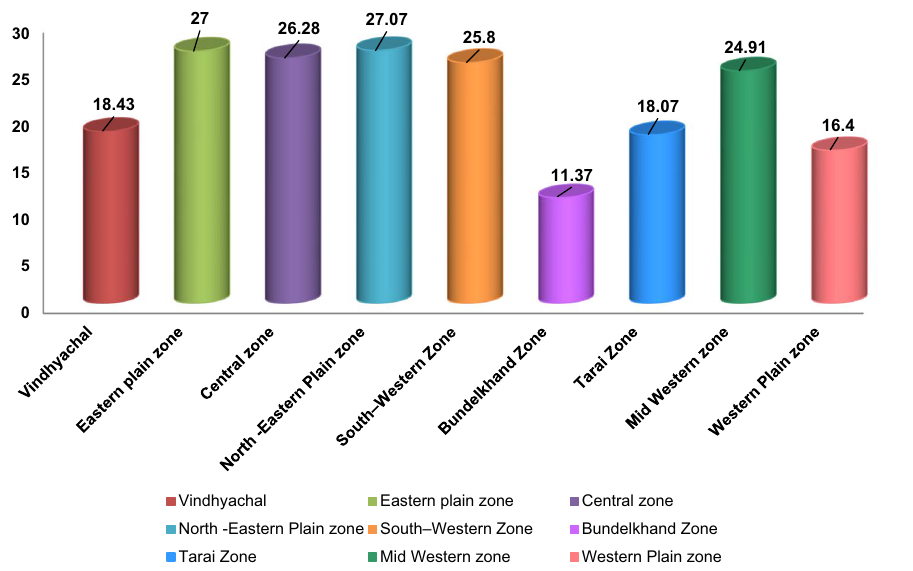
Figure 2. Viral disease incidence on cucurbits across the different agroclimatic zones of Uttar Pradesh.